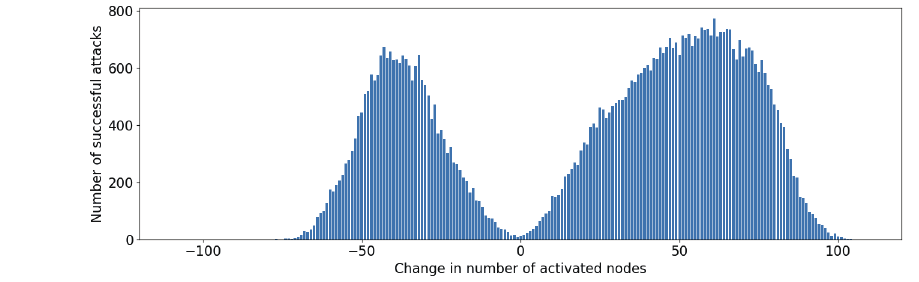
Figure 6: Simulation of relationship between the change in the number of all layers’ activated nodes and the number of successful attacks (misclassification) in the MLP model with